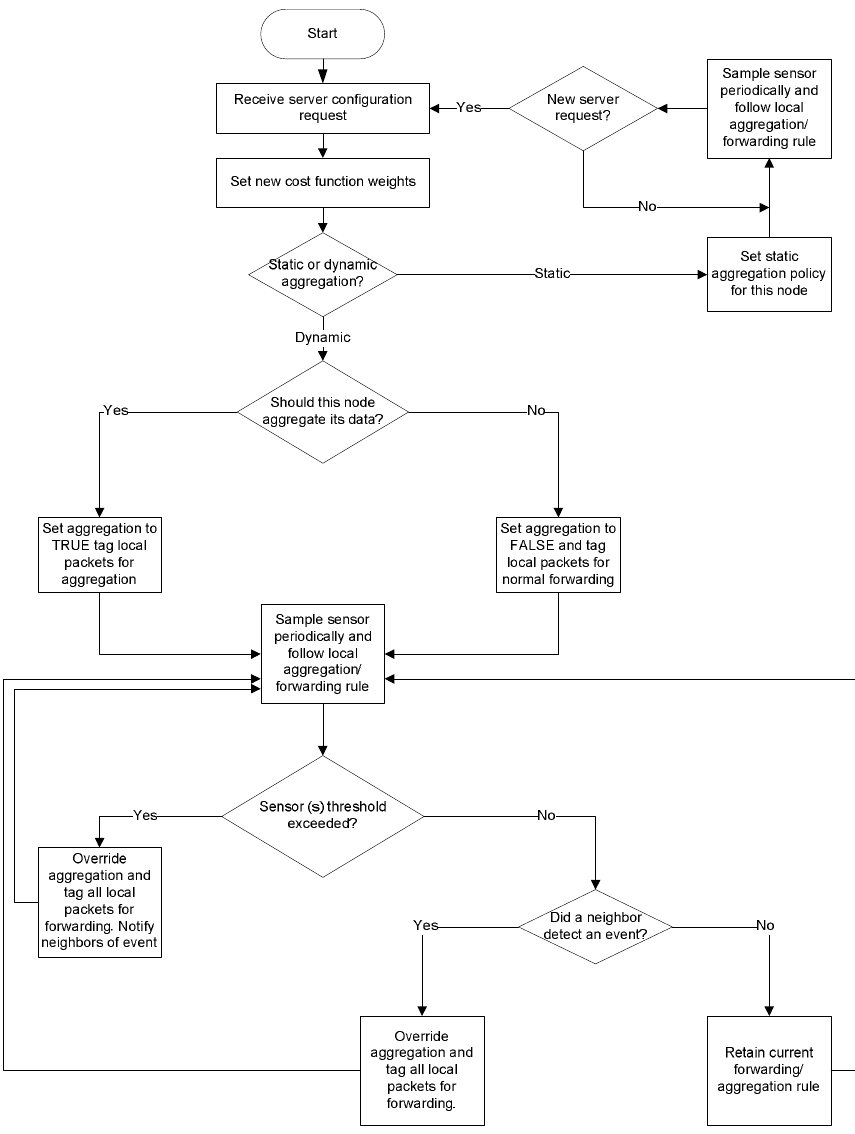
Figure 5. The effect of the feedback mechanism at the